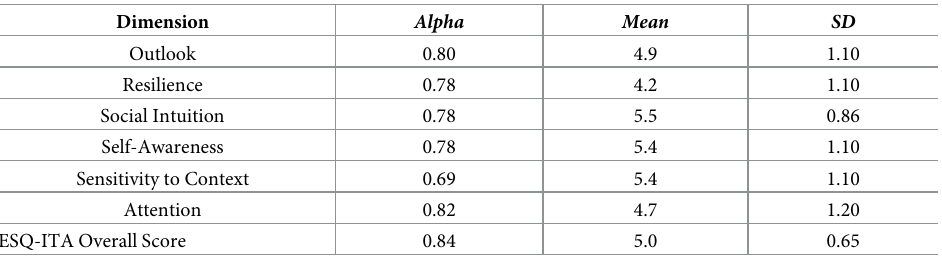
Cronbach’s alpha estimates for each dimension identified and the total score following the exclusion of subjects with anxiety and depression cut-offs greater than 10 and 14, respectively. The mean value plus standard deviation (SD) for the items that made up each dimension and the ESQ-ITA overall score were also